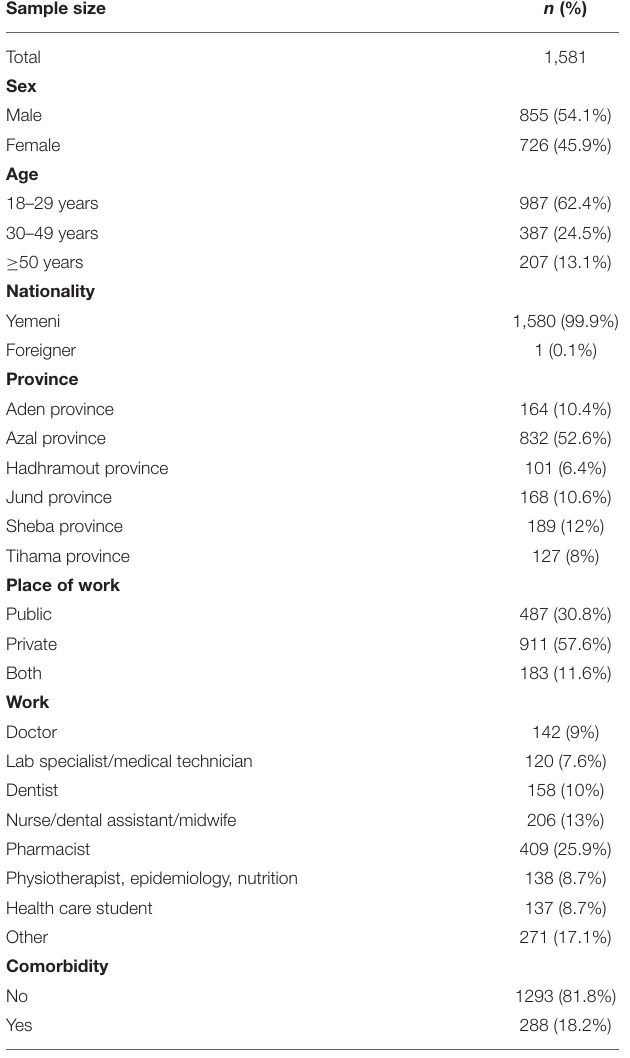
TABLE 1 | Sample characteristics: data are presented as n (%). Sample size